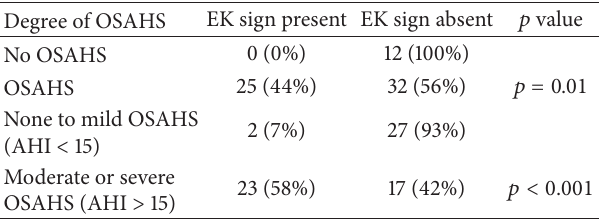
Table 2: EK sign according to presence and severity of